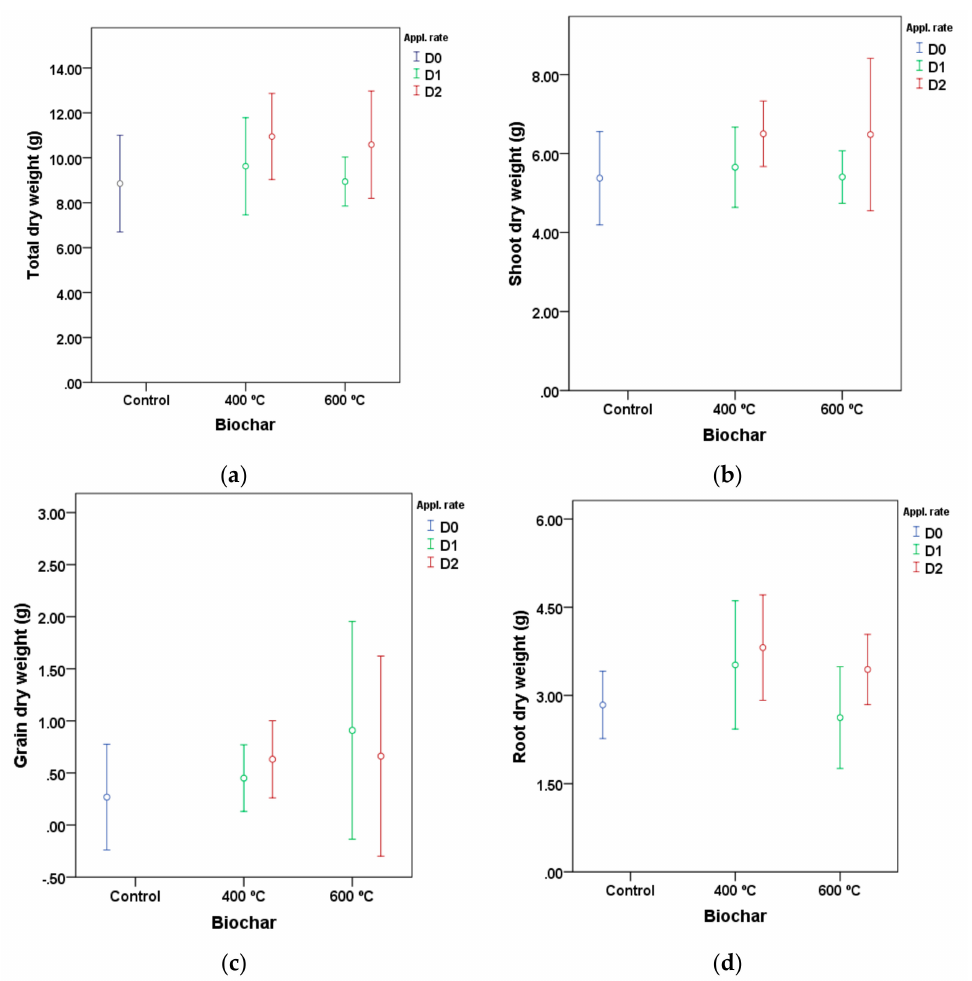
Figure 1. Main value and confidence interval at 95% of biomass dry weight on the second cycle of a sorghum crop under di ff erent application rates (0 wt. %—D0; 1.5 wt. %—D1; 3 wt. %—D2) of biochar at 400 ◦ C and 600 ◦ C. ( a ) total dry weight, ( b ) shoot dry weight, ( c ) grain dry weight, ( d ) root dry weight; average values between the sandy-loam growing substrate (S1) and the clay-loam growing substrate